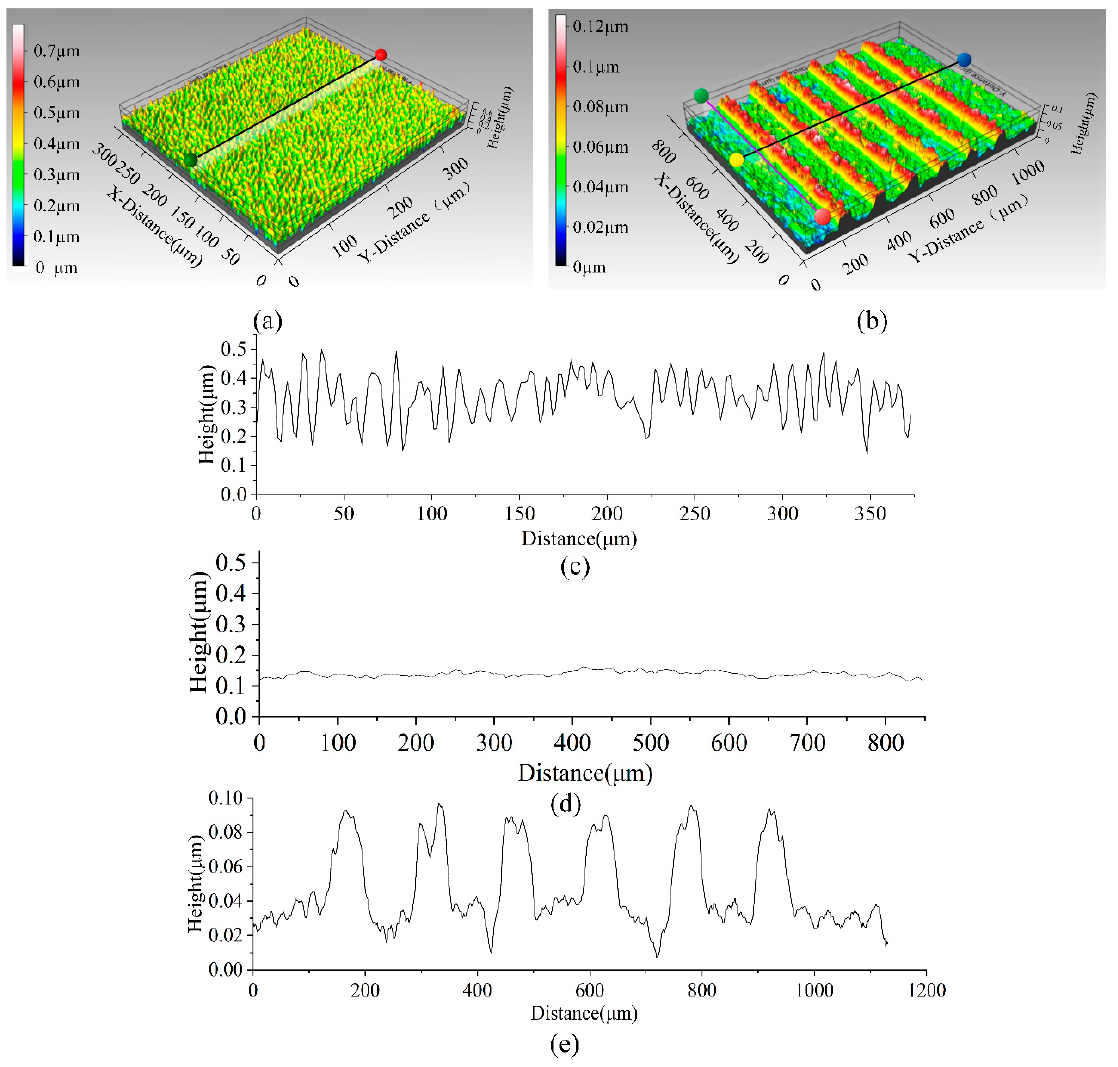
Figure 7. ( a ) Contour of the surface before treatment, ( b ) contour of the heating resistor after preparation, ( c ) height of the section before treatment as indicated by the black line in ( a ), ( d ) height of the section along the purple line in ( b ) after treatment, and ( e ) height diagram along the black line in ( b ) after treatment.